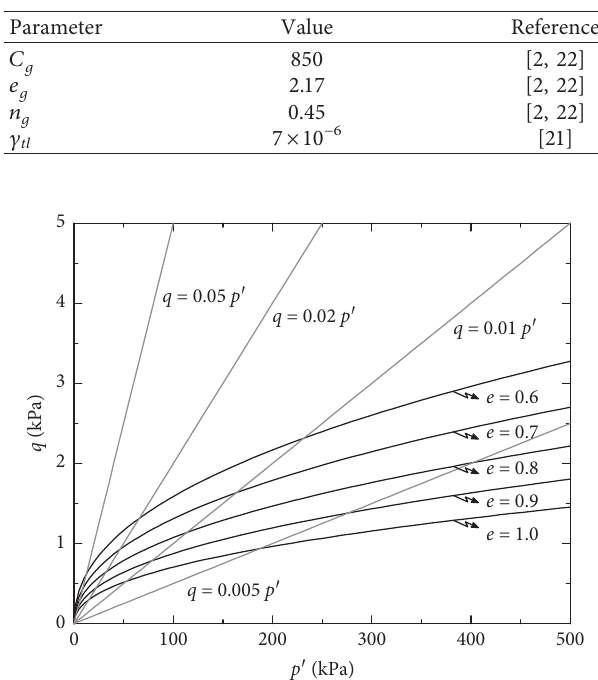
Figure 3: The calibrated yield surfaces (black lines) for Toyoura sand with various void ratio (0.6 to 1.0) compared with the linear yield surfaces (grey